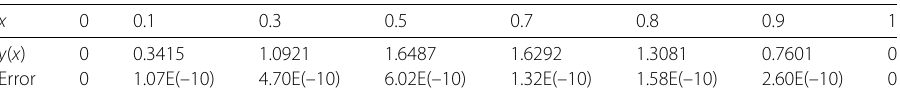
Table 3 For Example 4, showing the numerical solutions and the absolute errors obtained by the BSFM at different